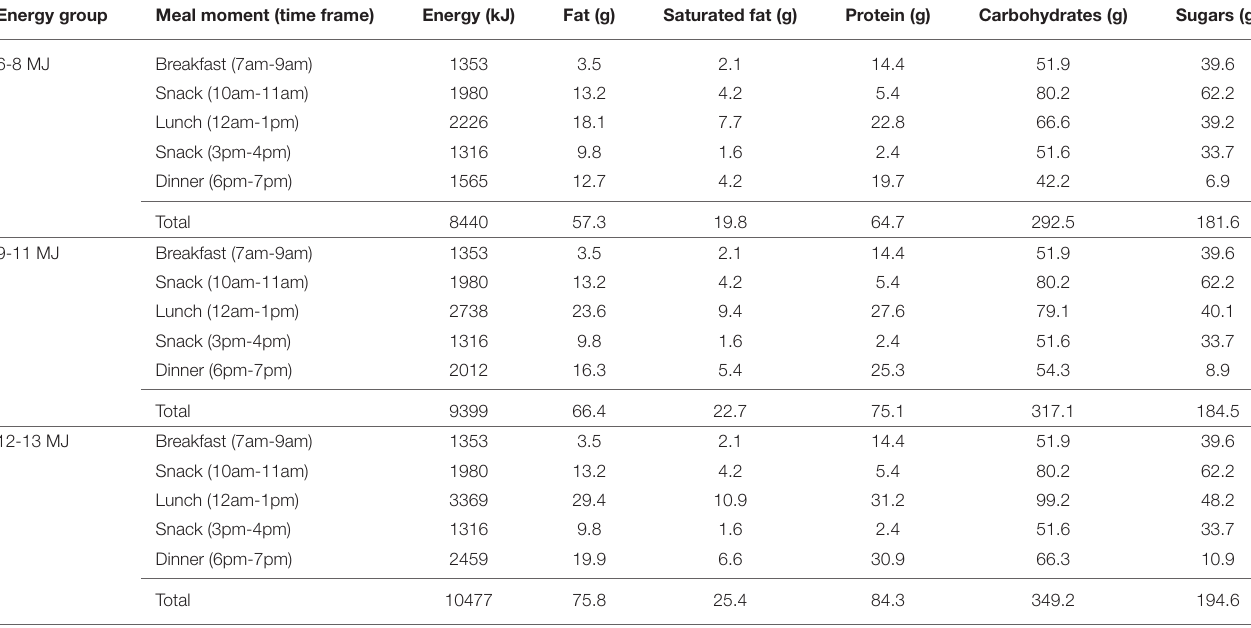
Supplementary Table 4 | Macronutrient composition of standardized meal moments during home-days per energy group. Energy